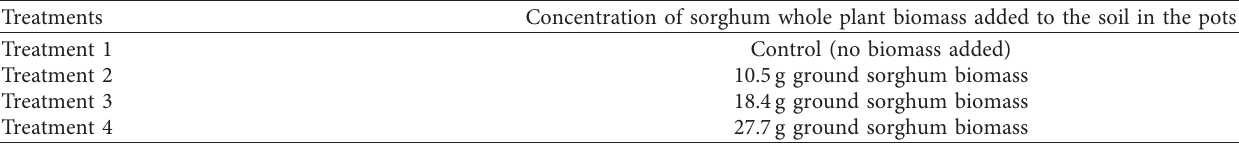
Table 2: Treatments used in the soil incorporated biomass greenhouse experiment.